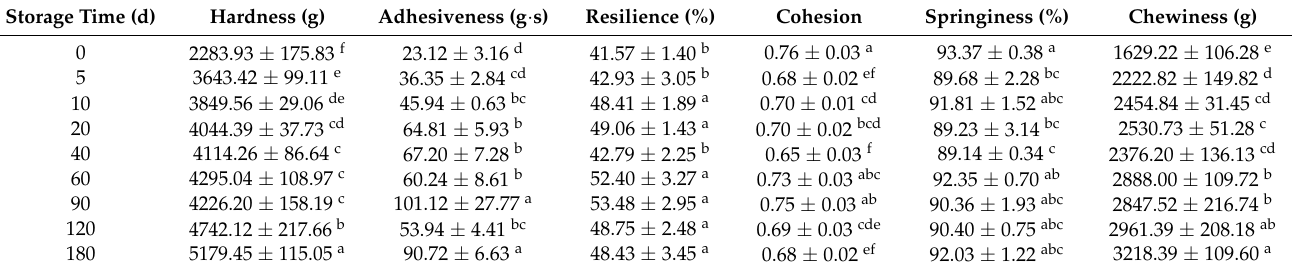
Table 2. Changes in textural properties of semi-dried rice noodles during